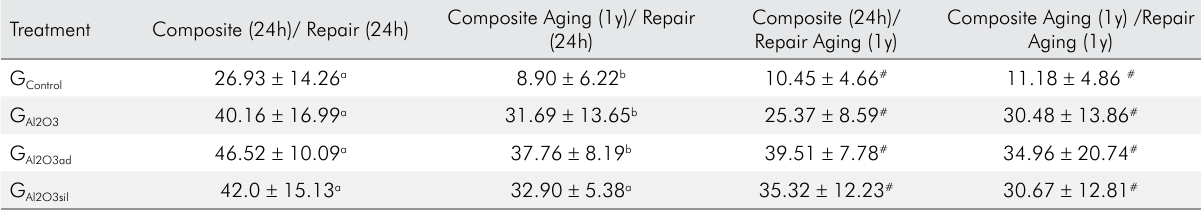
Table 3. Mean and standard deviation ( ± SD) of bond strength of composite and repair according to storage time of composite ageing.